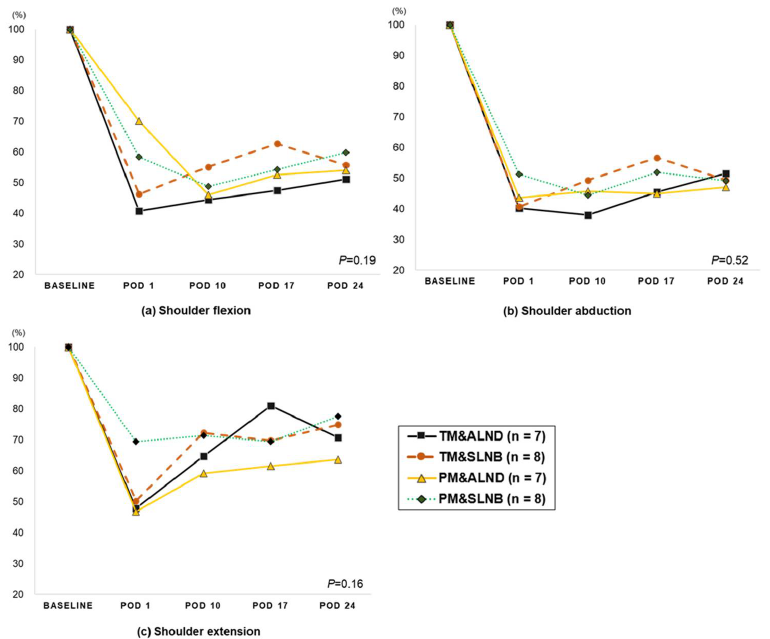
Figure 2. The changes in the shoulder strength after breast surgery according to the surgery type in the affected side (descriptive) . P : the repeated measure of ANOVA analysis (group*time interac- tion). Abbreviation: Total mastectomy with axillary lymph node dissection; TM with ALND, Total mastectomy with sentinel node biopsy; TM c SLNB, Partial mastectomy with axillary node dissection; PM with ALND, Partial mastectomy with sentinel node biopsy; PM with SLNB, Postopera- tive day: POD